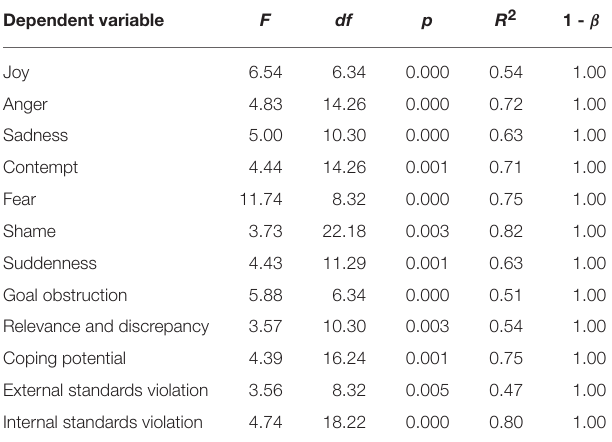
TABLE 3 | Results of final models in stepwise regression